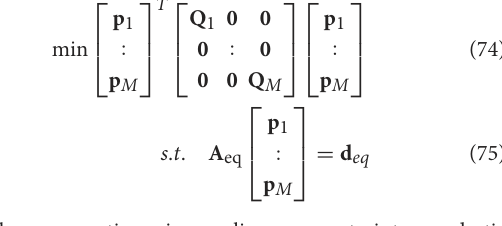
The above equation is a linear constraint quadratic programming problem